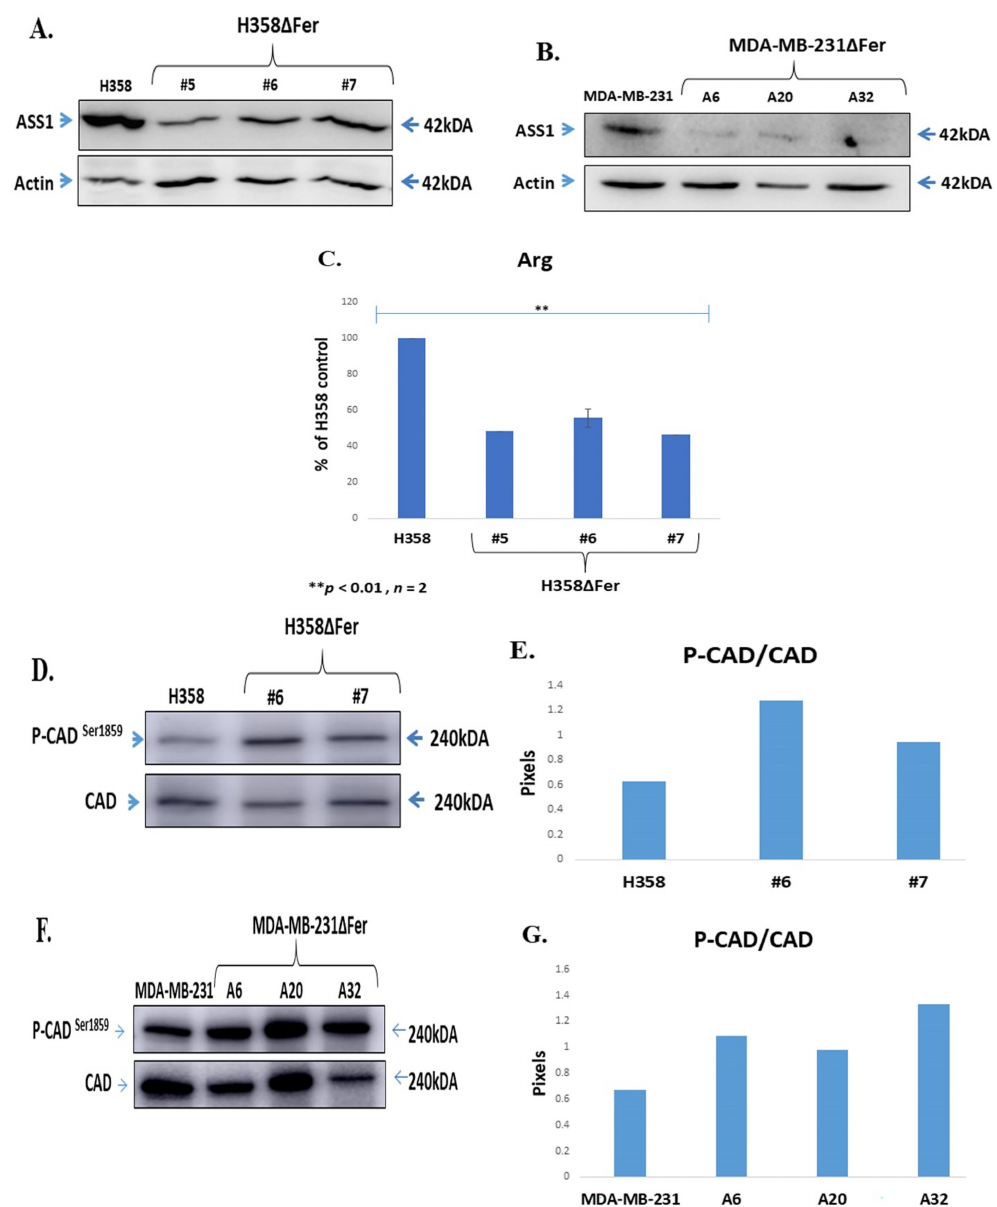
Figure 6. Down-regulated urea cycle in Fer-deficient H358 ∆ Fer and MDA-MB-231 ∆ Fer cells. ( A ) WB analysis depicting the relative expression levels of Argininosuccinate Synthase 1 (ASS1) in H358 and H358 ∆ Fer cells and ( B ) in MDA-MB-231 and MDA-MB-231 ∆ Fer cells. Actin served as a loading control. ( C ) Decreased arginine levels in H358 ∆ Fer cells grown in the absence of glucose. Histograms represent means +/ − SE of 2 independent experiments (** p -values < 0.01). ( D , E ) WB analysis depicting the relative expression levels of phospho- carbamoyl-phosphate synthetase 2, aspartate transcarbamylase, and dihydrooroatase (p-CAD) in H358 and H358 ∆ Fer and ( F , G ) in MDA-MB-231 and MDA-MB-231 ∆ Fer cells. CAD pan levels served as a loading control. ( E , G ) Quantification of the results presented in ( D , F ), respectively. These results represent one out of two independent experiments which gave similar